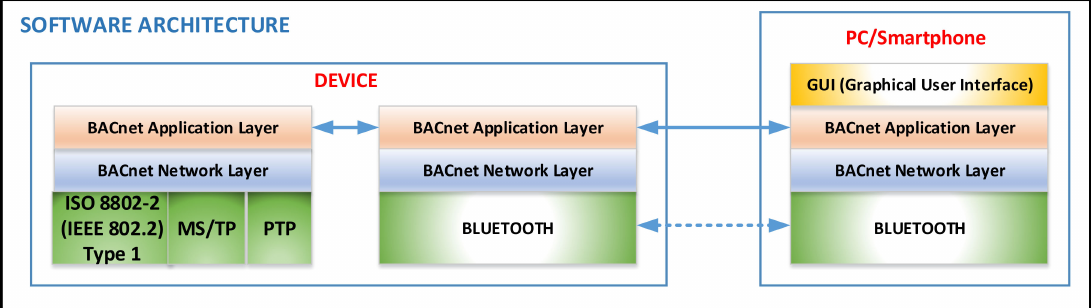
Figure 3. The software architecture of the proposed